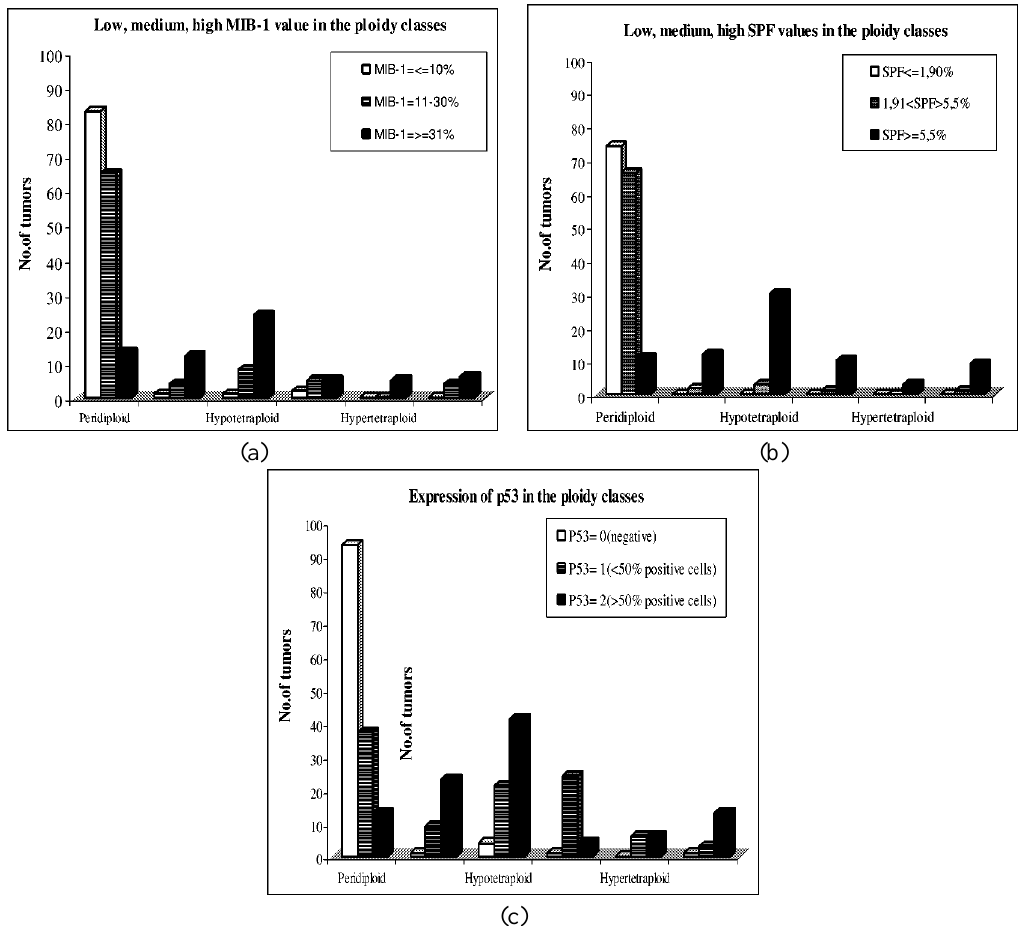
Fig. 7. Bar histograms showing the relation existing between ploidy classes and MIB-1 (a), SPF values (b) and expression of p53 (c). The hypotetraploid class was the one showing the highest percentage of cases with poor prognostic